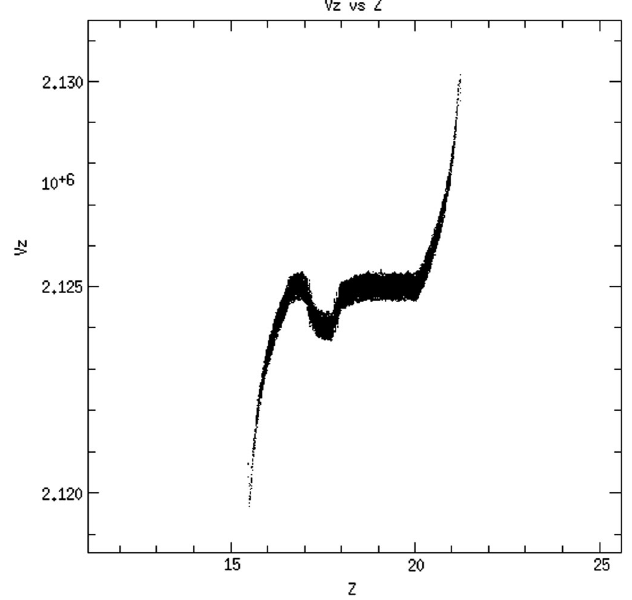
FIG. 1. An example to illustrate the disturbed phase space for a high generalized perveance Rb beam due to the head-to-tail nonlinearity and the gap voltage